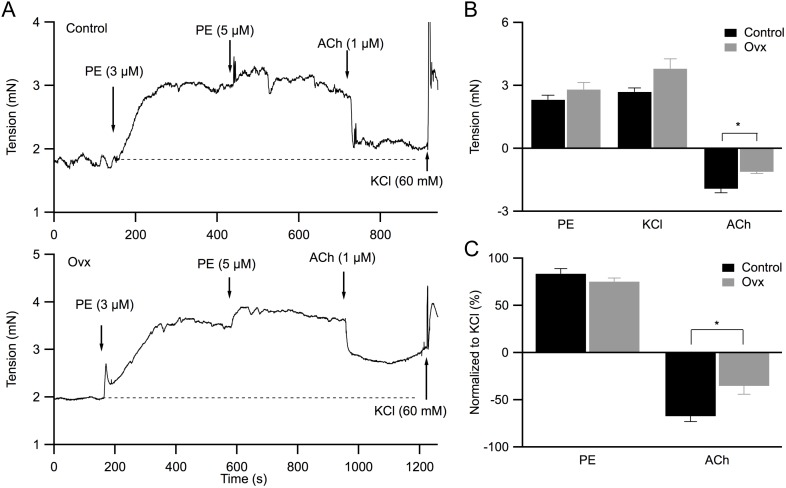
Compromised ACh-induced relaxation in ovx mesenteric vessels.
A: Representative force myograph traces showing isometric tension (mN) plotted against the time of recording (s) using control (top panel) and ovx (bottom panel) mesenteric vessels. Bath application of PE (3 and 5 µM) induced vasoconstriction, ACh (1 µM) induced vasorelaxation, was followed by bath solution replacement with physiological salt solution containing 60 mM KCl that induced vasoconstriction. B: Summary of isometric tension changes induced by PE (3 uM), KCl, and ACh for both control (black) and ovx (grey) vessels. Negative values show vasorelaxation. C: Tension changes normalized to the KCl-induced contraction for both PE and ACh. Ovx vessels show reduced ACh response. Asterisk (*) denotes statistical significance (P<0.05, t-test).